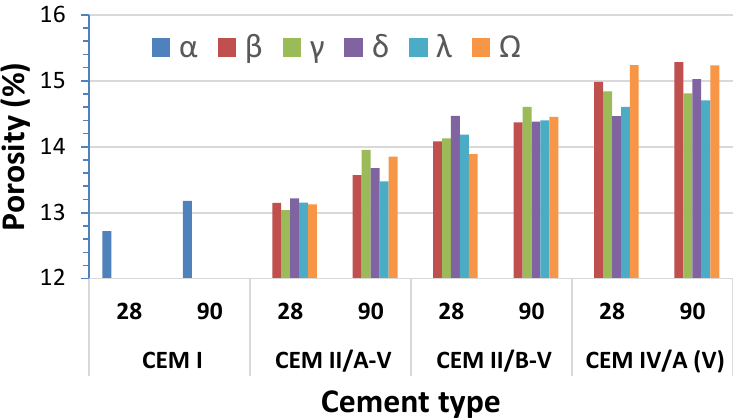
Figure 12. Effective or accessible porosity of mortars.